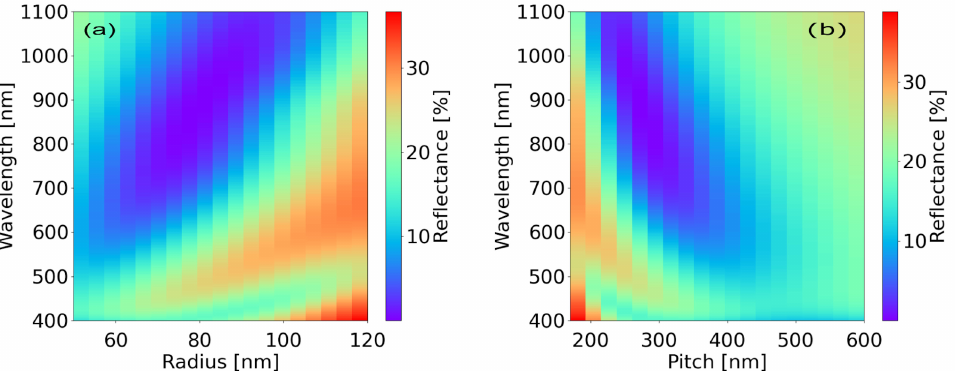
Figure 5. The effect of varying radius ( a ) and pitch ( b ) of the reflectance of a hexagonal InP array on a Si substrate with a InP nanodisk height of